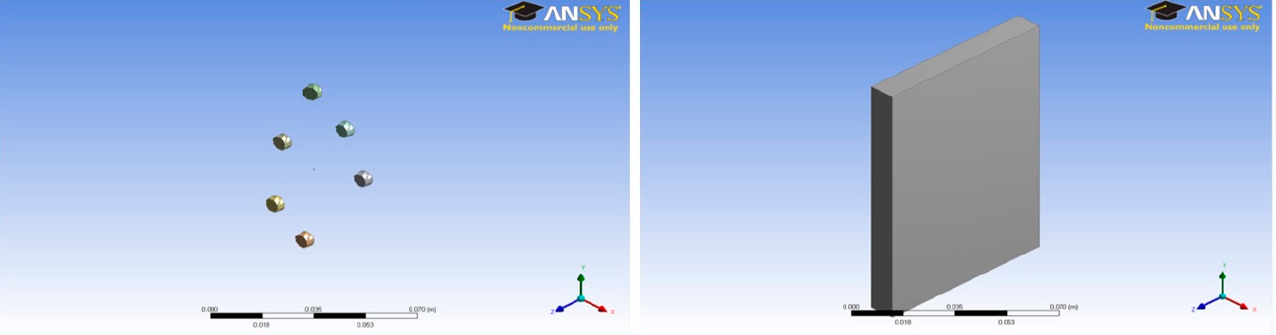
Figure 8. Three percent coarse aggregate sample model (11 × 7 × 1 cm) and concrete slab.